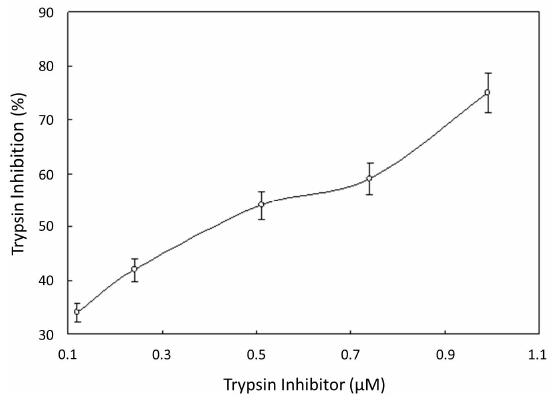
Figure 2. Inhibition of trypsin by GBTI . IC 50 = 0.4 μ M. Results are presented as mean ± SD ( n =